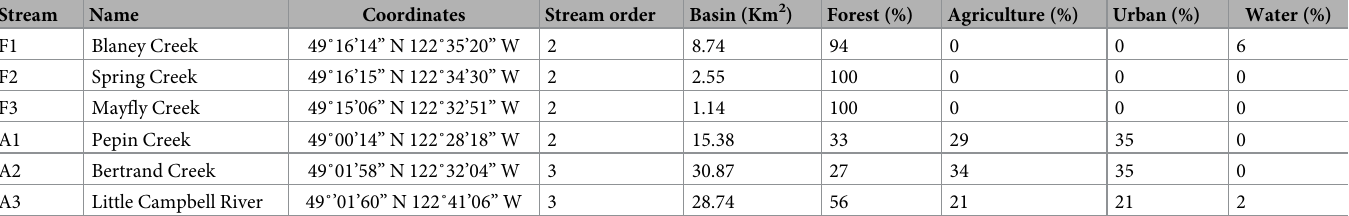
Table 1. Main characteristics of the studied streams. Land covered data obtained from the Land Use 2010 map by the Canada Government (https://open.canada.ca/ data/en/).